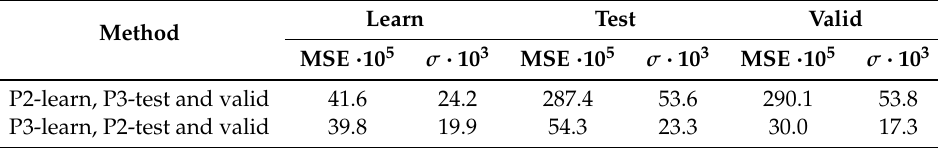
Table 4. Comparison of the learning, testing, and validation errors: P2P3.